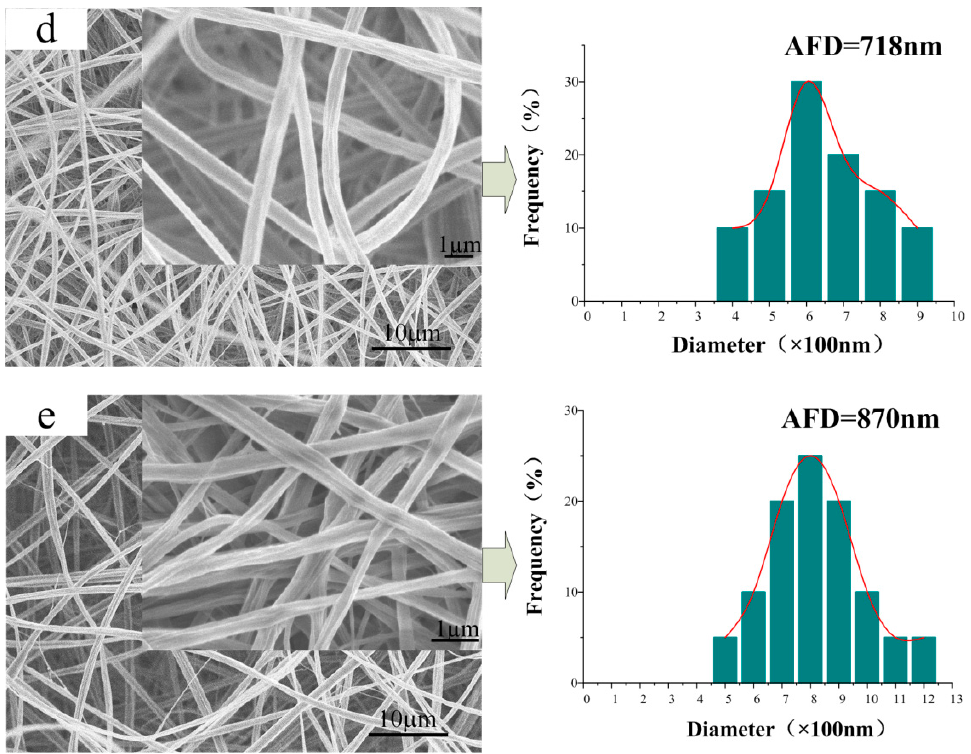
Figure 1. SEM images of a series of CA/PVP nanofibers with varying PVP contents ( a ) 0%; ( b ) 0.5%; ( c ) 1%; ( d ) 2%; ( e ) 5%. The pictures on the right correspond to the diameter distributions.